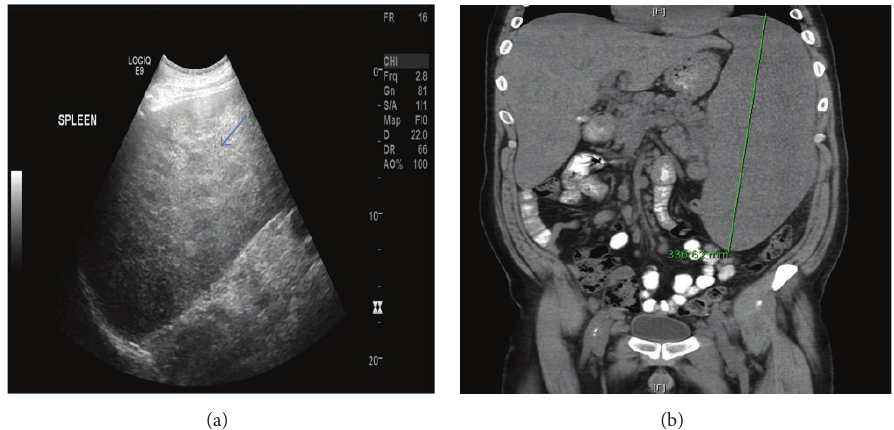
Figure 1: Massive splenomegaly. (a) Sagittal sonographic view of the spleen showing a markedly enlarged and diffuse heterogeneous spleen (blue arrow) measuring 30 cm in length. (b) Coronal noncontrast CT of the abdomen and pelvis showing enlarged spleen reaching 33.6 cm in length.